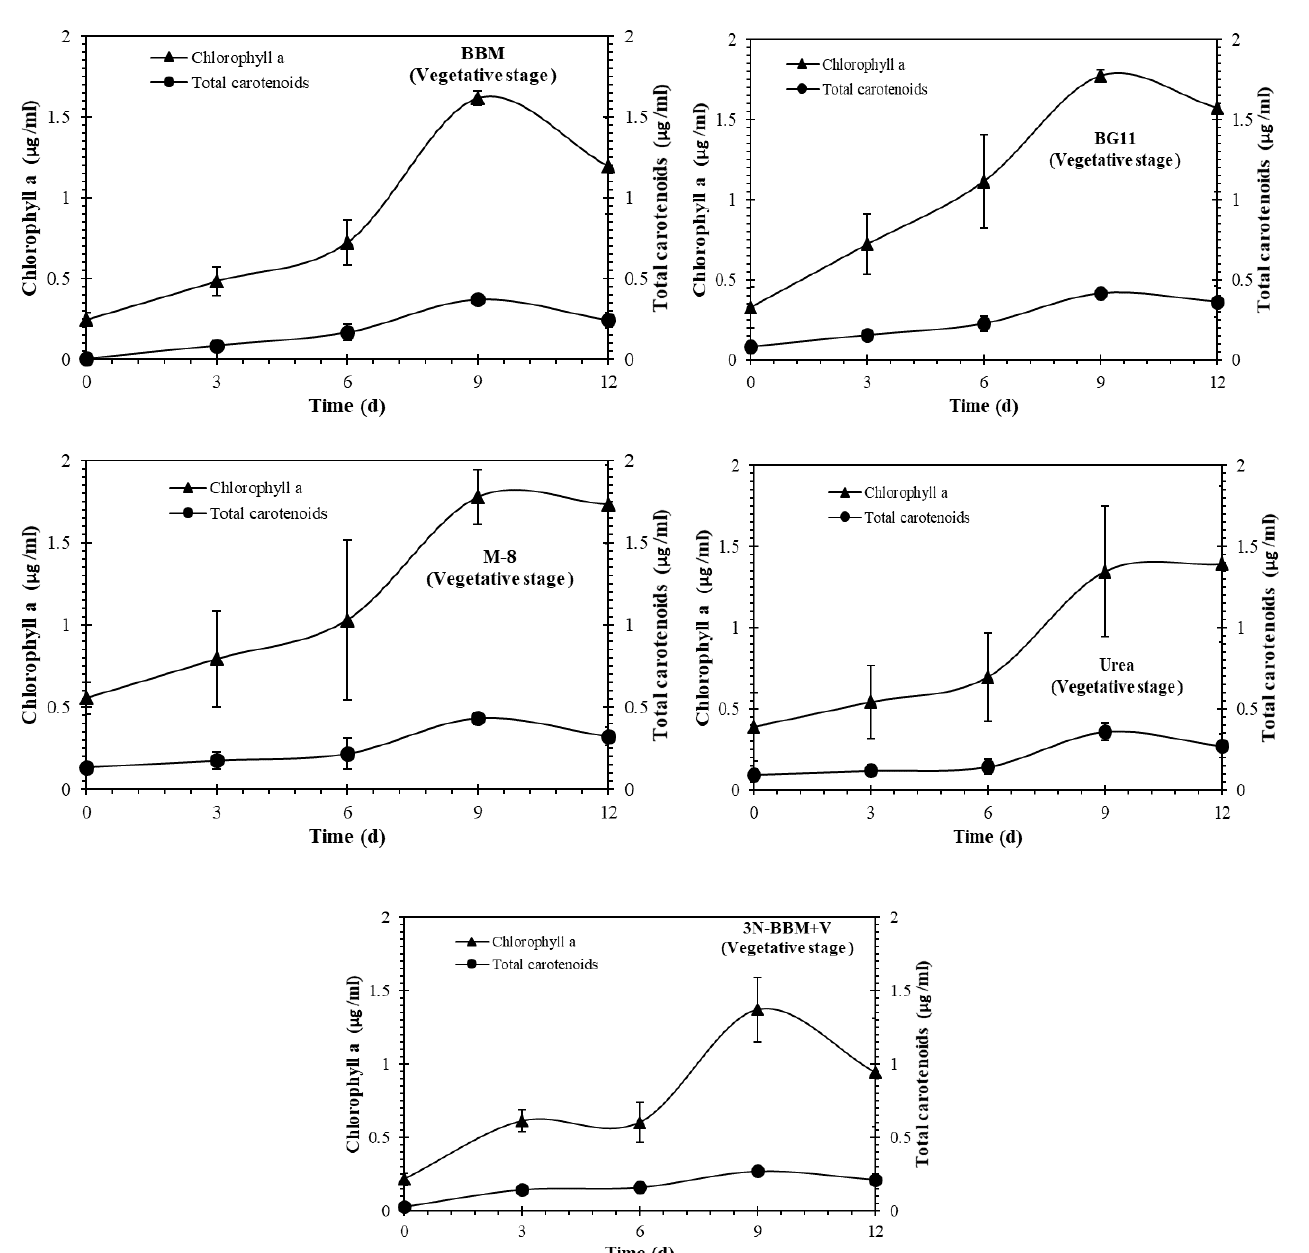
Figure 3. Chlorophyll a and carotenoid production in Coelastrella sp. in the vegetative stage during cultivation in different media. The vegetative stage involved culturing under 40 µ mol m − 2 s − 1 illumination, 16:8 (light:dark) photoperiod, for 12 days. Cultures were maintained in a mixed state by bubbling with a mixture of 3% CO 2 in N 2 . Results represent mean ± SD of three replicates.